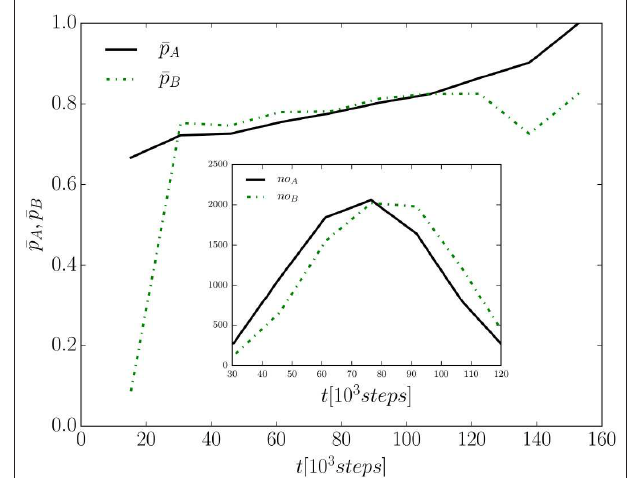
p A ( t ) and p B ( t ) computed using a (temporal) bin ¯ ¯ 160 10 3 , and the population size is ≈ ×